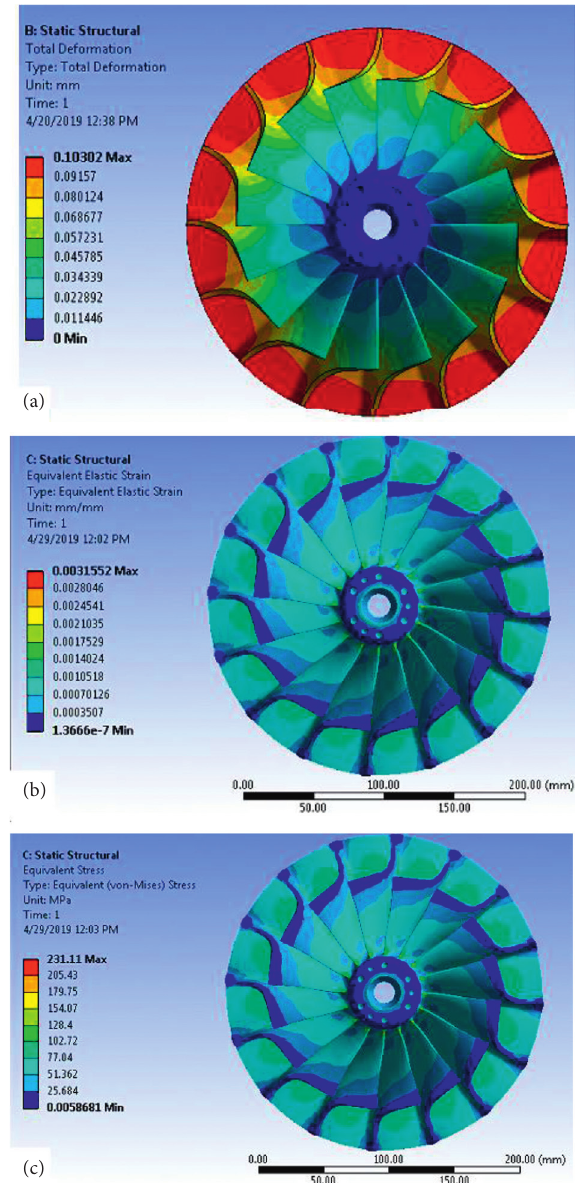
Figure 15: The extracted contour of (a) total deformation (b) elastic strain (c) Von-Mises stress for pressure difference 0.1 bar in 34500rpm.